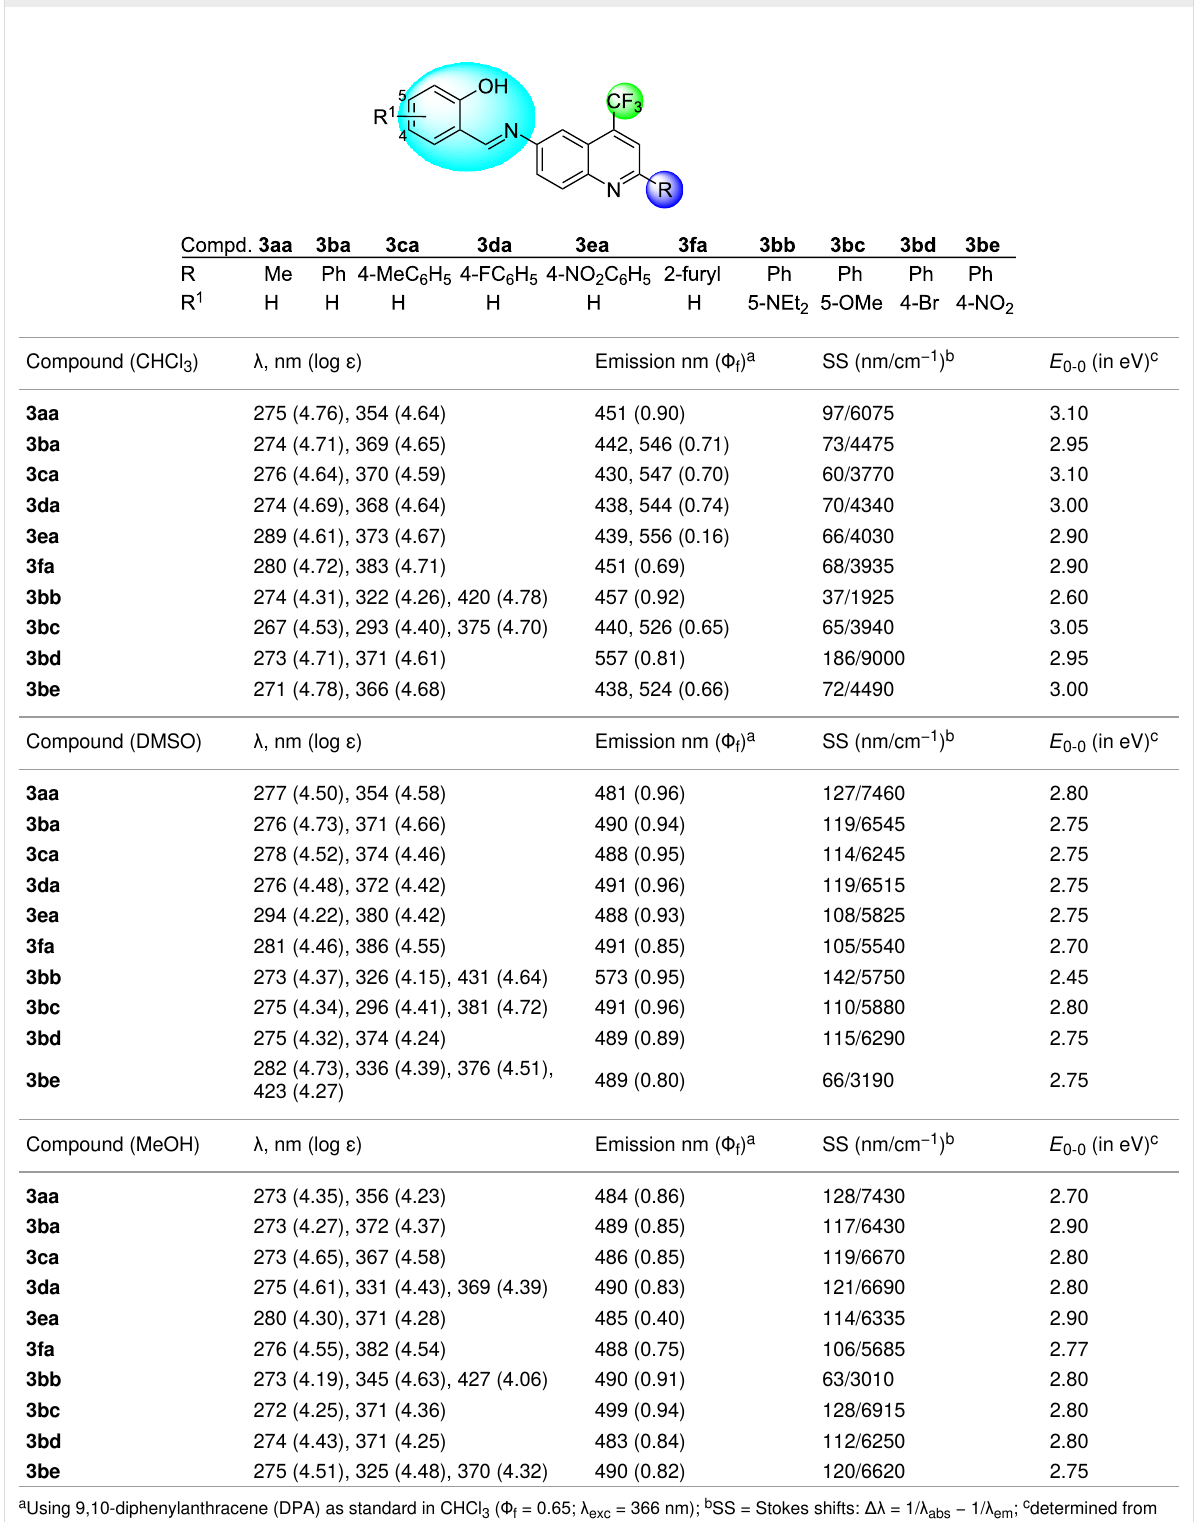
Table 1: Photophysical data of derivatives 3aa – fa and 3bb – be ([ ] = 1.50 × 10 − 5